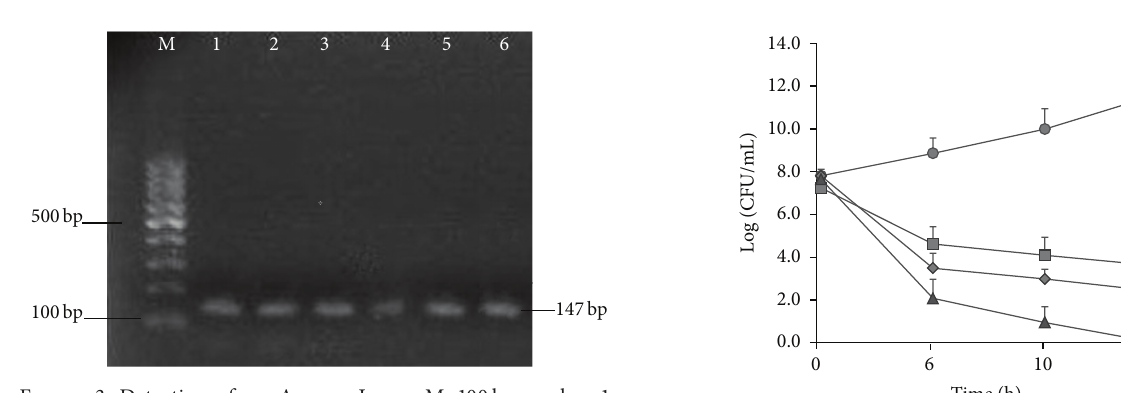
Figure 3: Detection of mec A gene. Lanes: M: 100bp marker, 1– 6: 147bp PCR product of mec A gene from strains Staphylococcus epidermidis Sep1–Sep6.